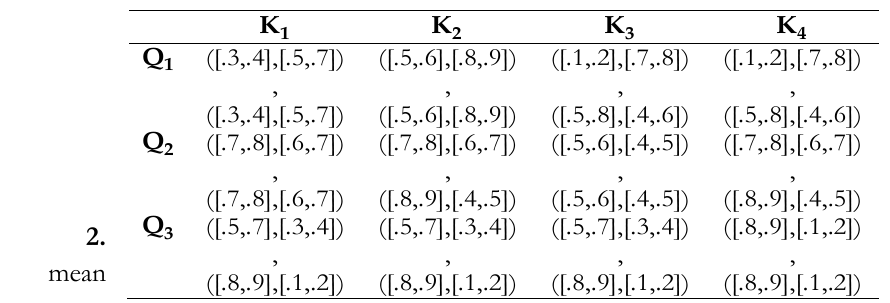
Table 1. Decision